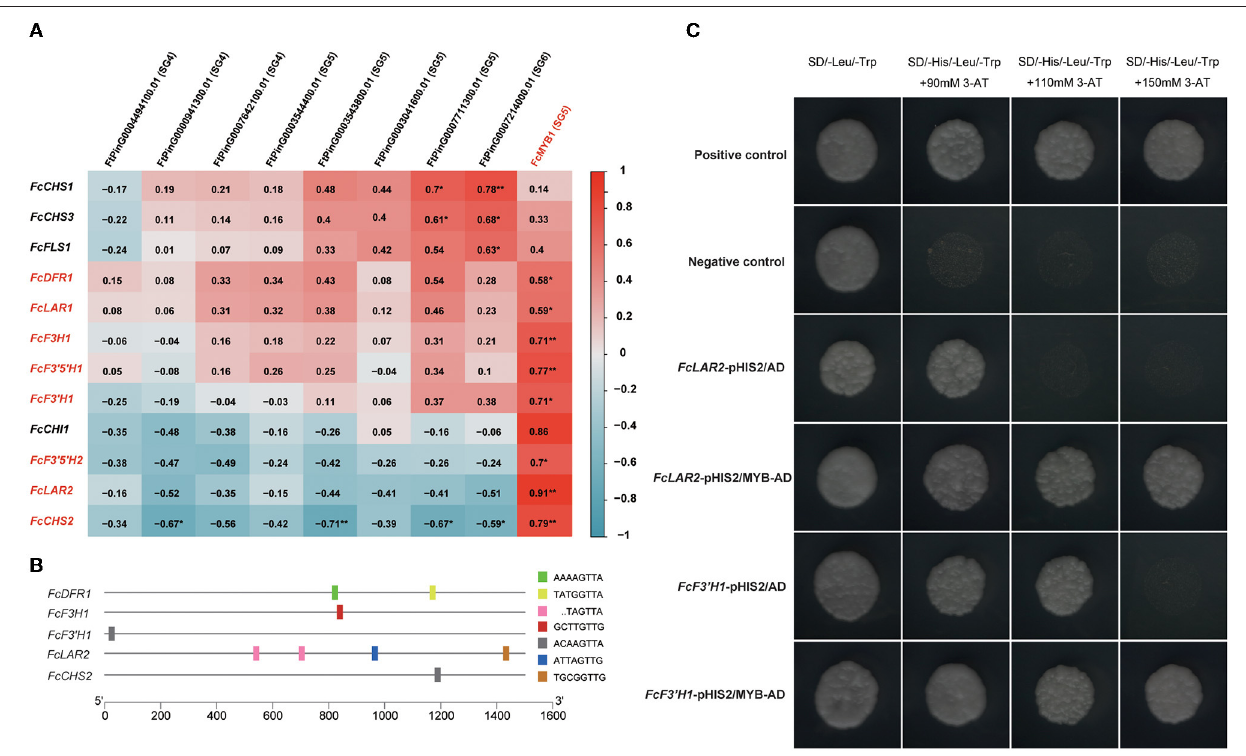
FIGURE 4 | MYB transcription factor (TF) regulated flavonoid biosynthesis. (A) Pearson correlations of flavonoid biosynthesis DEGs and MYB DEGs. (B) DNA-binding specificities of R2R3-MYB TFs identified in the promoters of flavonoid biosynthesis DEGs. (C) Yeast one-hybrid analysis of FcMYB1 to examine the binding of the protein to the promoters of flavonoid biosynthesis